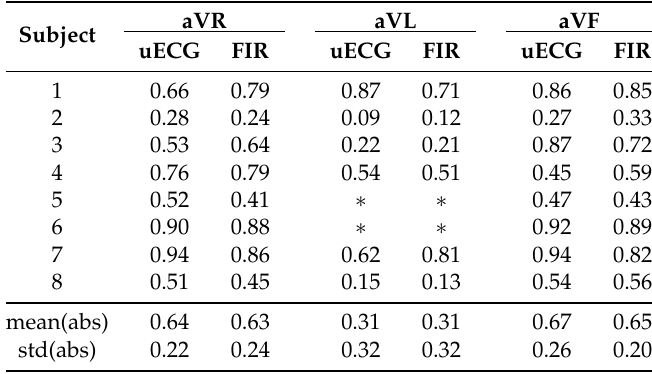
Table 3. Leave-one-out correlation coefficients for finite impulse response (FIR), compared to uECG.